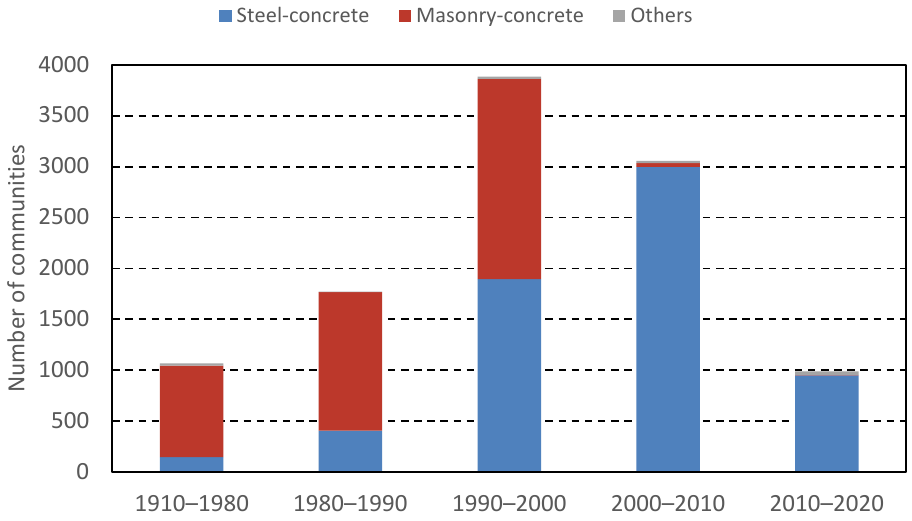
Figure 7. Quantities and proportions of communities in different periods.